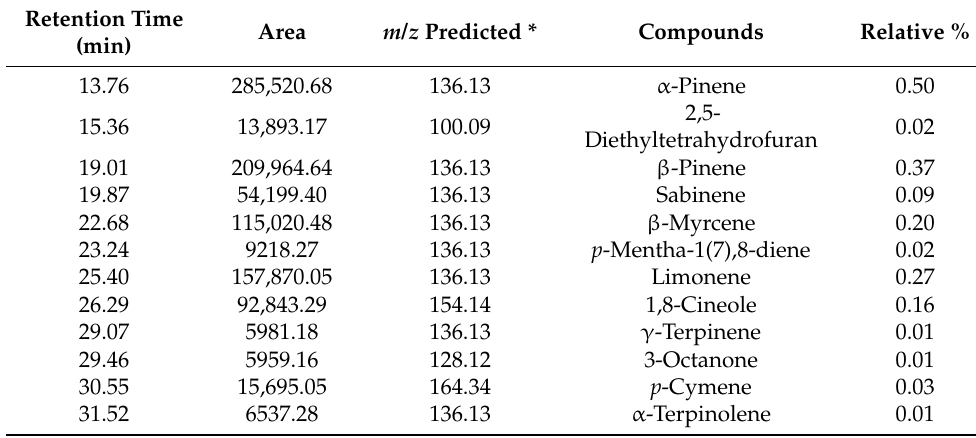
Figure 1. GC-FID chromatogram of the pennyroyal EO. Table 1. Chemical composition of pennyroyal EO assessed by GC